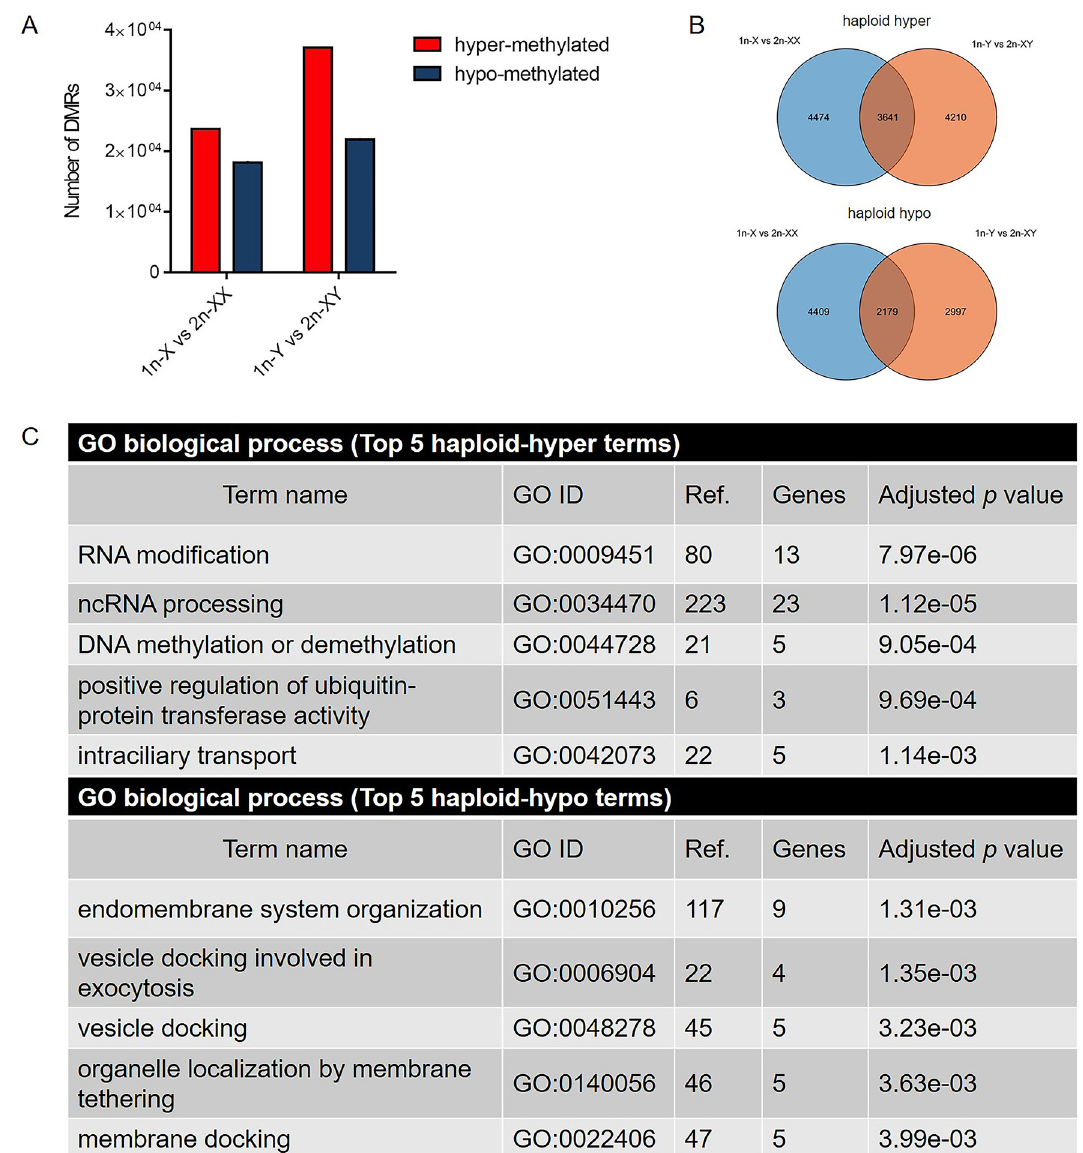
Figure 3. 1n-X vs. 2n-XX and 1n-Y vs. 2n-XY comparisons in tiger pufferfish ( T. rubripes ). ( A ) Number of promoter region DMRs between haploid and diploid female and male tiger pufferfish. ( B ) Venn diagram of haploid hyper-methylated/haploid hypo-methylated DMGs between males and females, respectively. ( C ) Top 5 enriched GO biological processes of haploid hyper-methylated/ haploid hypo-methylated DMGs shared in female and male tiger